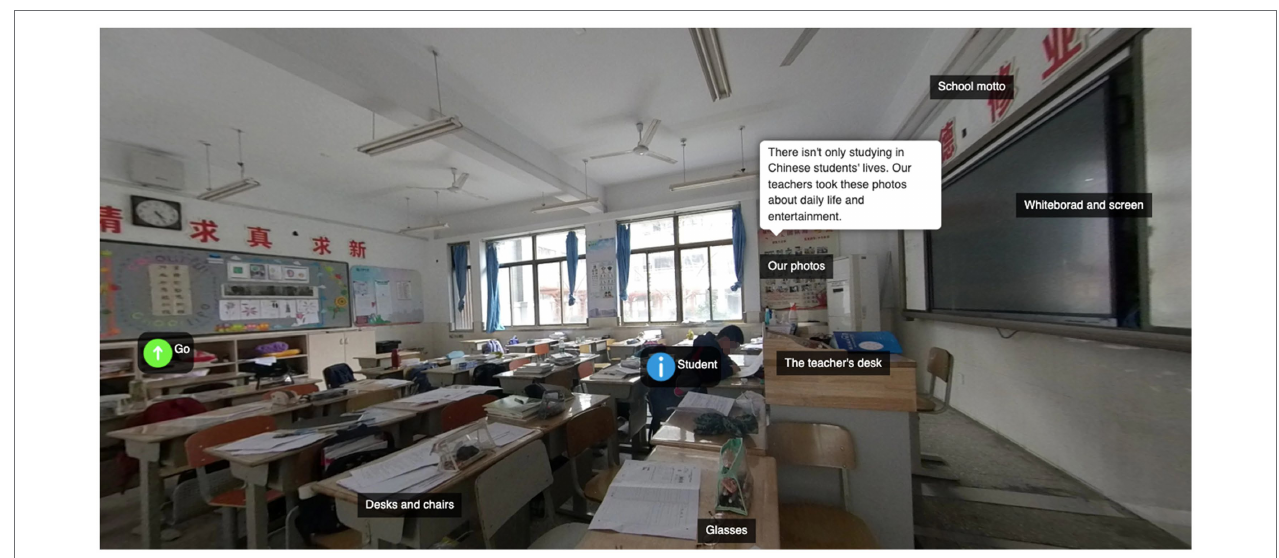
FIGURE 2 | Created content (panoramic tour) of student ID3.